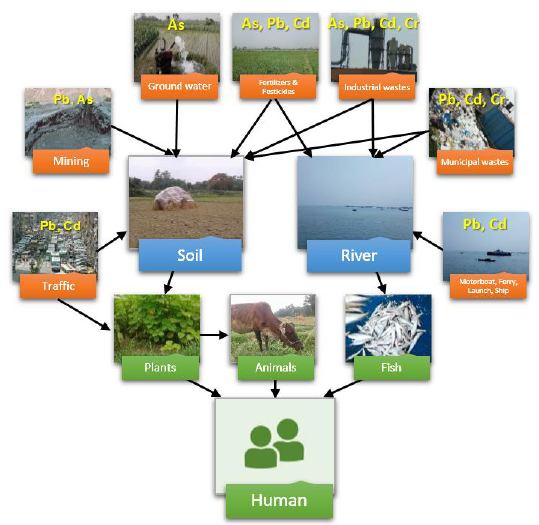
Figure 1. Major pathways of heavy metal and metalloid dispersion and human exposure in Bangladesh.